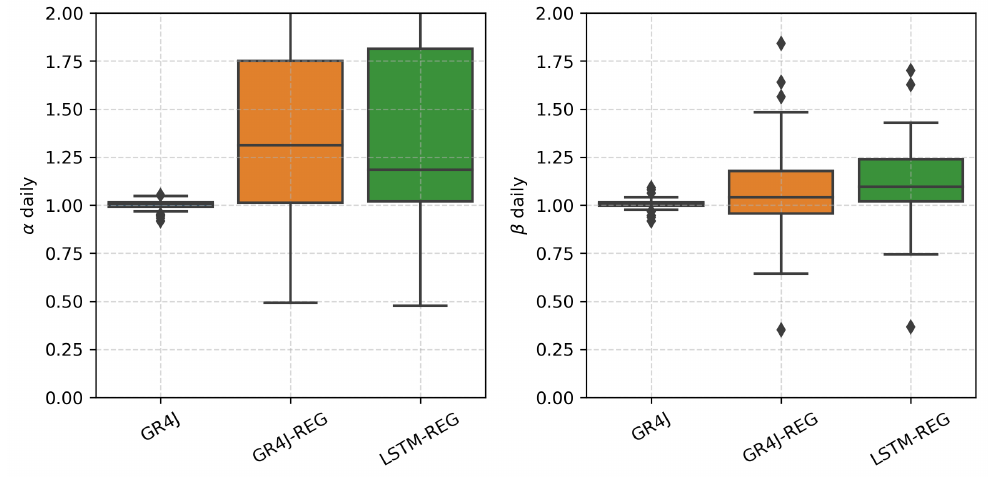
Figure 9. Performance evaluation results of GR4J-REG and LSTM-REG gridded runoff datasets in comparison with the results of GR4J basin-scale calibration in terms of the variability component α ( left plot ) and bias component β ( right plot ) of the Kling–Gupta efficiency. The results are presented in the form of box